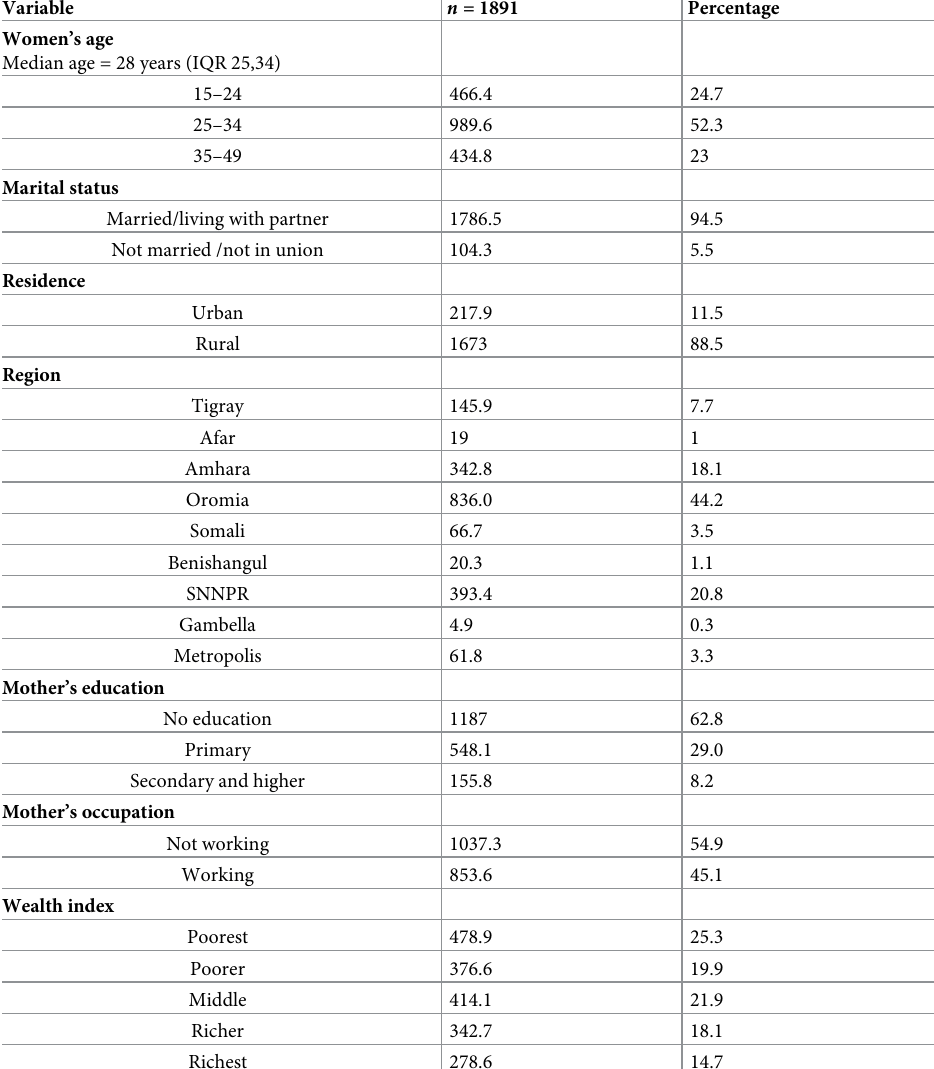
Table 1. Background characteristics of the study population, Ethiopian Demographic Health Survey, 2016.